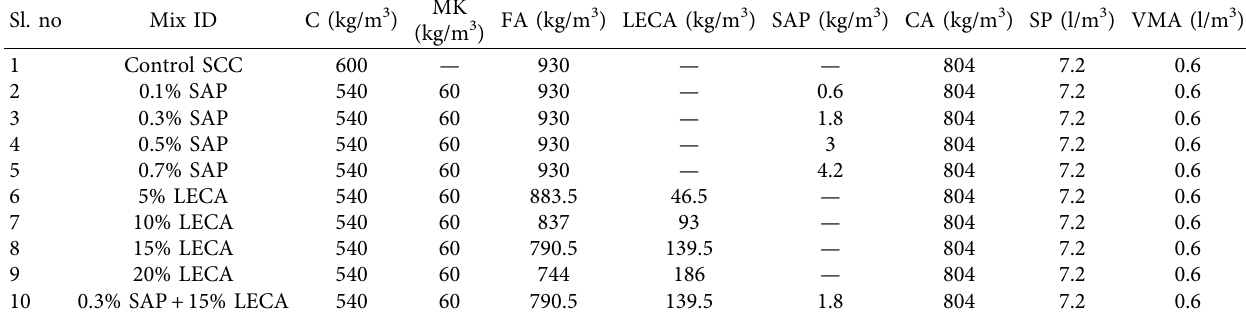
Table 3: Mix proportions.